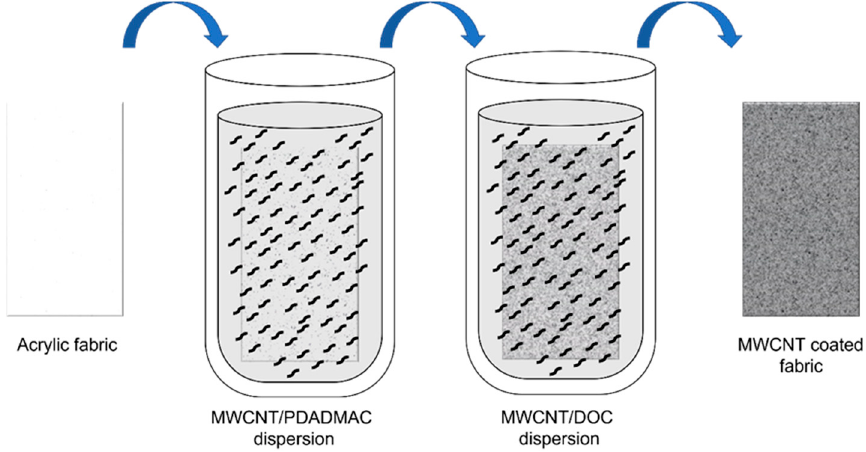
Figure 1. Schematic process of layer-by-layer (LbL) coating of felt fabrics with